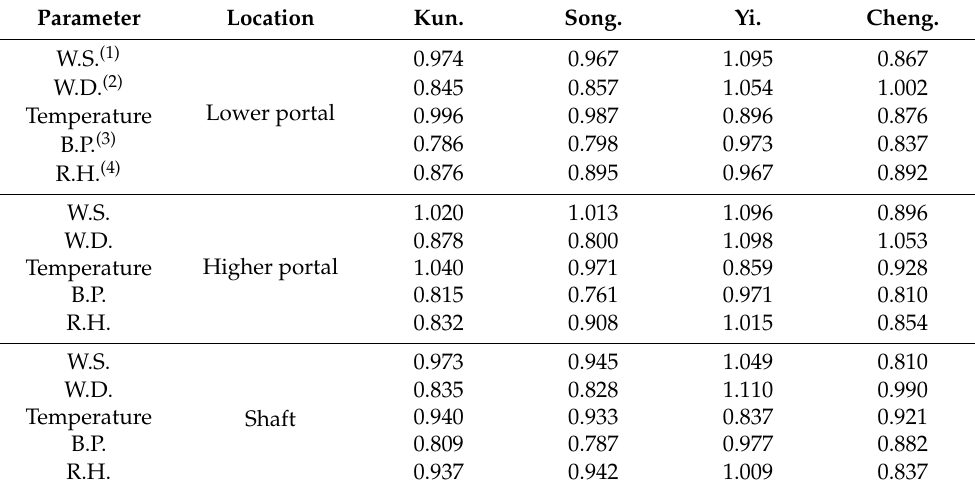
Table 3. Meteorological parameter prediction weight